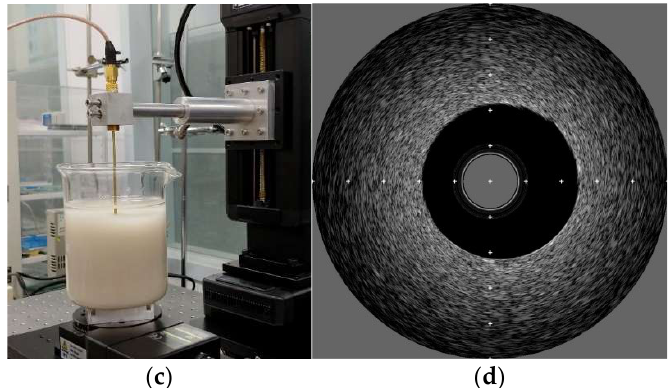
Figure 11. Experimental setups and 360 ◦ rotated B-modes images for the proposed IVUS transducer: ( a ) Experimental setup for wire phantom; ( b ) B-mode image of wire phantom; ( c ) experimental setup for tissue-mimic gelatin phantom; and ( d ) B-mode image of tissue-mimic gelatin phantom.